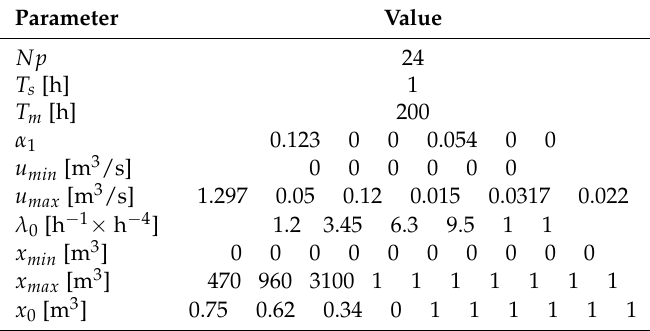
Table 2. Simulation